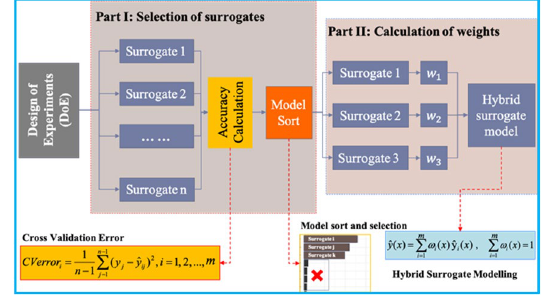
Figure 2 Construction of the E-AHF